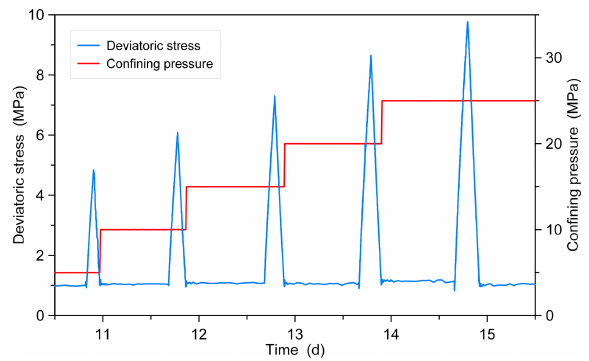
Figure 11. Stepwise changes of the confining pressure (red) and loading-unloading cycles shown through changes in the effective pressure (blue). Figure 12. Sample from BDB-1 borehole (drill depth from 179.29